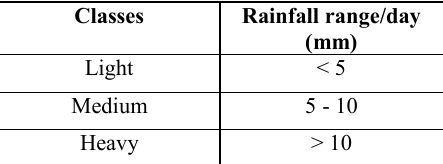
Table 1. Classification of rainfall events